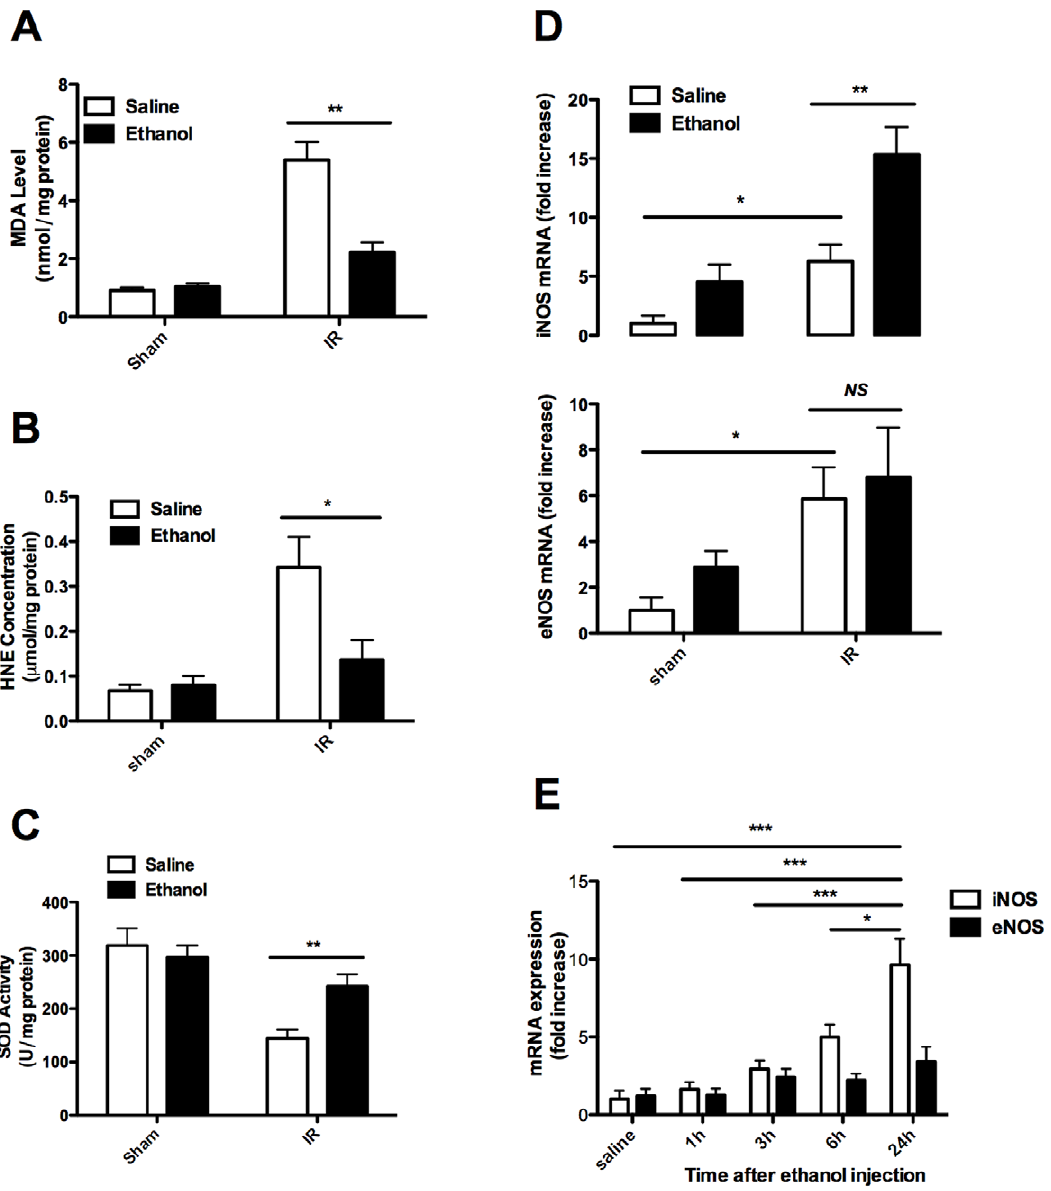
Figure 5. Ethanol pretreatment ameliorated oxidative stress after renal IR. Mice were pretreated with saline or 1 g/kg ethanol, and were exposed to a 30-min bilateral renal IR 3 h later. Kidney samples were collected at 24 h post reperfusion for assay of: A. MDA levels; B. HNE levels; and C. SOD activities; and D. iNOS & eNOS expression. E. Mice were pretreated with saline or ethanol (1 g/kg) and exposed to a 30-min bilateral renal ischemia after different time interval. Kidney samples were collected at 24 h post reperfusion for assay of iNOS & eNOS expression. Results are mean values 6 SEM. ( n =4–6). (* p , 0.05, ** p , 0.01).